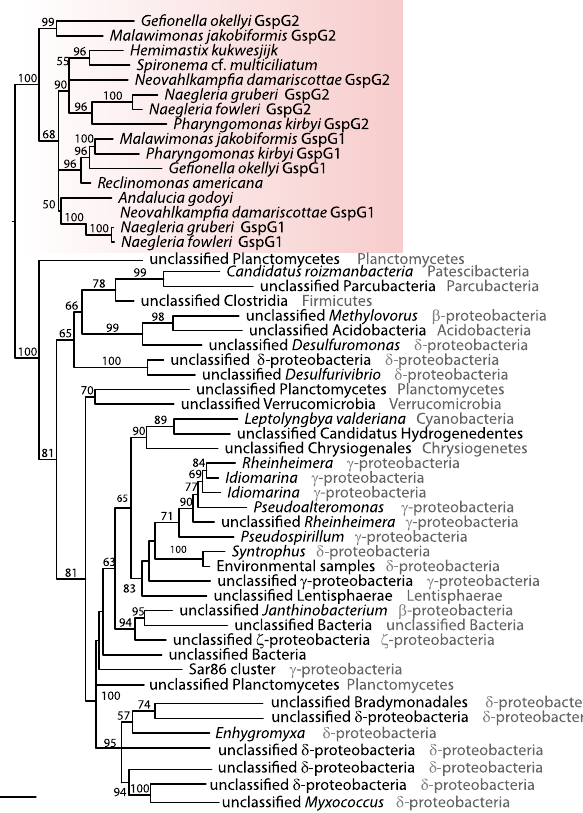
Fig. 2 Eukaryotic Gsp homologues are monophyletic. Maximum likelihood (ML) phylogenetic tree of eukaryotic and selected bacterial GspG proteins demonstrating the monophyletic origin of the eukaryotic GspG proteins and their separation from bacterial homologues by a long branch (the tree inferred using IQ-TREE). Branch support (bootstrap) was assessed by ML ultrafast bootstrapping and is shown only for branches where support is